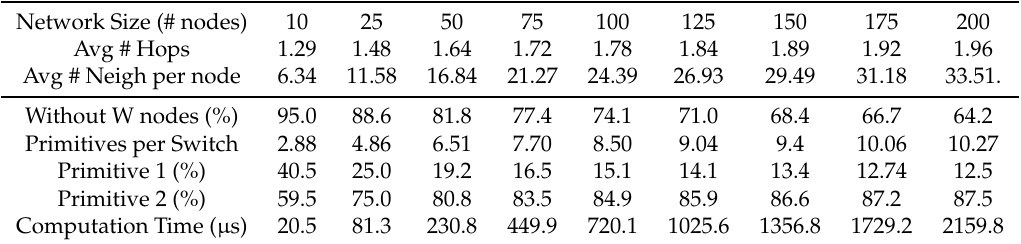
Table 5. Results of running the algorithm for different network sizes in the “ dense networks ” group. Network Size (#